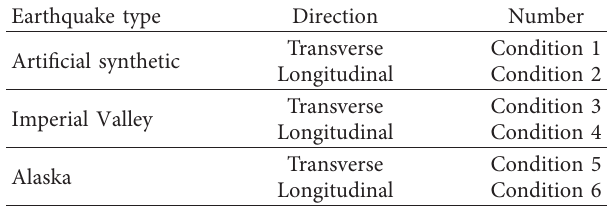
Figure 8: Earthquake acceleration time-history curves of intensity 7 fortification. (a) Synthesized (transverse input). (b) Synthesized (longitudinal input). (c) Imperial Valley (transverse input). (d) Imperial Valley (longitudinal input). (e) Alaska (transverse input). (f) Alaska (longitudinal input). Table 3: Experimental conditions (7-degree fortification).